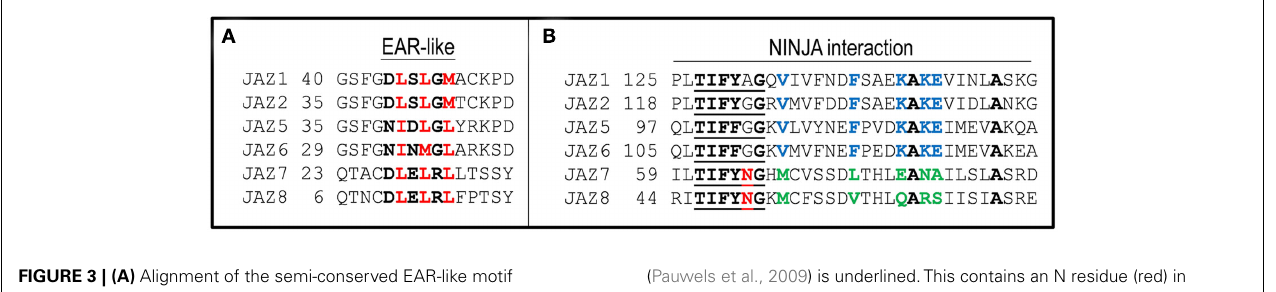
FIGURE 3 | (A) Alignment of the semi-conserved EAR-like motif present in the NT domain of select JAZ proteins. Specific residues comprising the EAR-like motif are shown in bold. Red residues indicate the key (leucine or similar). (B) Alignment of the C-terminal portion of JAZs sufficient for NINJA.TheTIFYXG motif required interaction